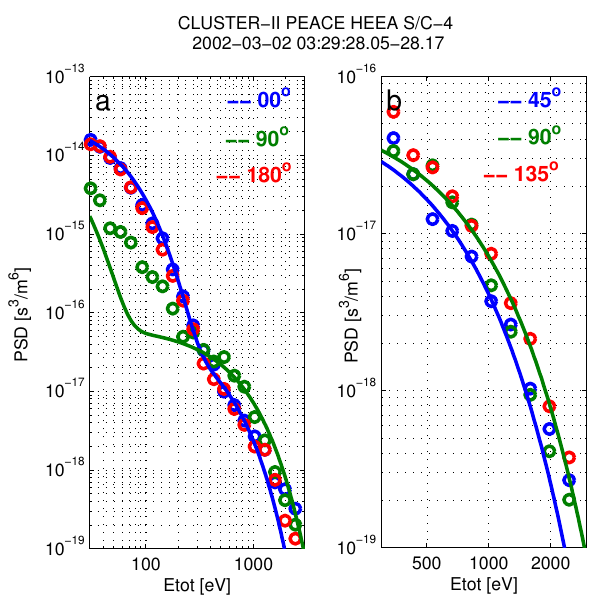
Fig. 10. Cross sections through the electron distribution function. (a) The phase space density of electrons for angles parallel, anti- parallel and perpendicular to the magnetic field. We see that for electron energies ranging from 20–200 eV, the phase space den- sity is clearly larger parallel/anti-parallel than perpendicular to the magnetic field, whereas the opposite is true for energies of 200 eV– 1 keV. The circles are observations while solid lines show the model used. (b) Phase space density of high energy electrons for pitch an- gles 45 ◦ , 90 ◦ and 135 ◦ . Data (circles) clearly shows that the phase space density is lower nearly parallel (45 ◦ ) than nearly anti-parallel (135 ◦ ). The model electron distributions for 90 ◦ and 45/135 ◦ are included (solid lines). Table 2. The second plasma model. All components are assumed to be Maxwellians. The model is based on PEACE and CIS observa- tions. Compared to Model 1, we assume slightly less cold electrons and introduce an inverse temperature anisotropy at higher energies.